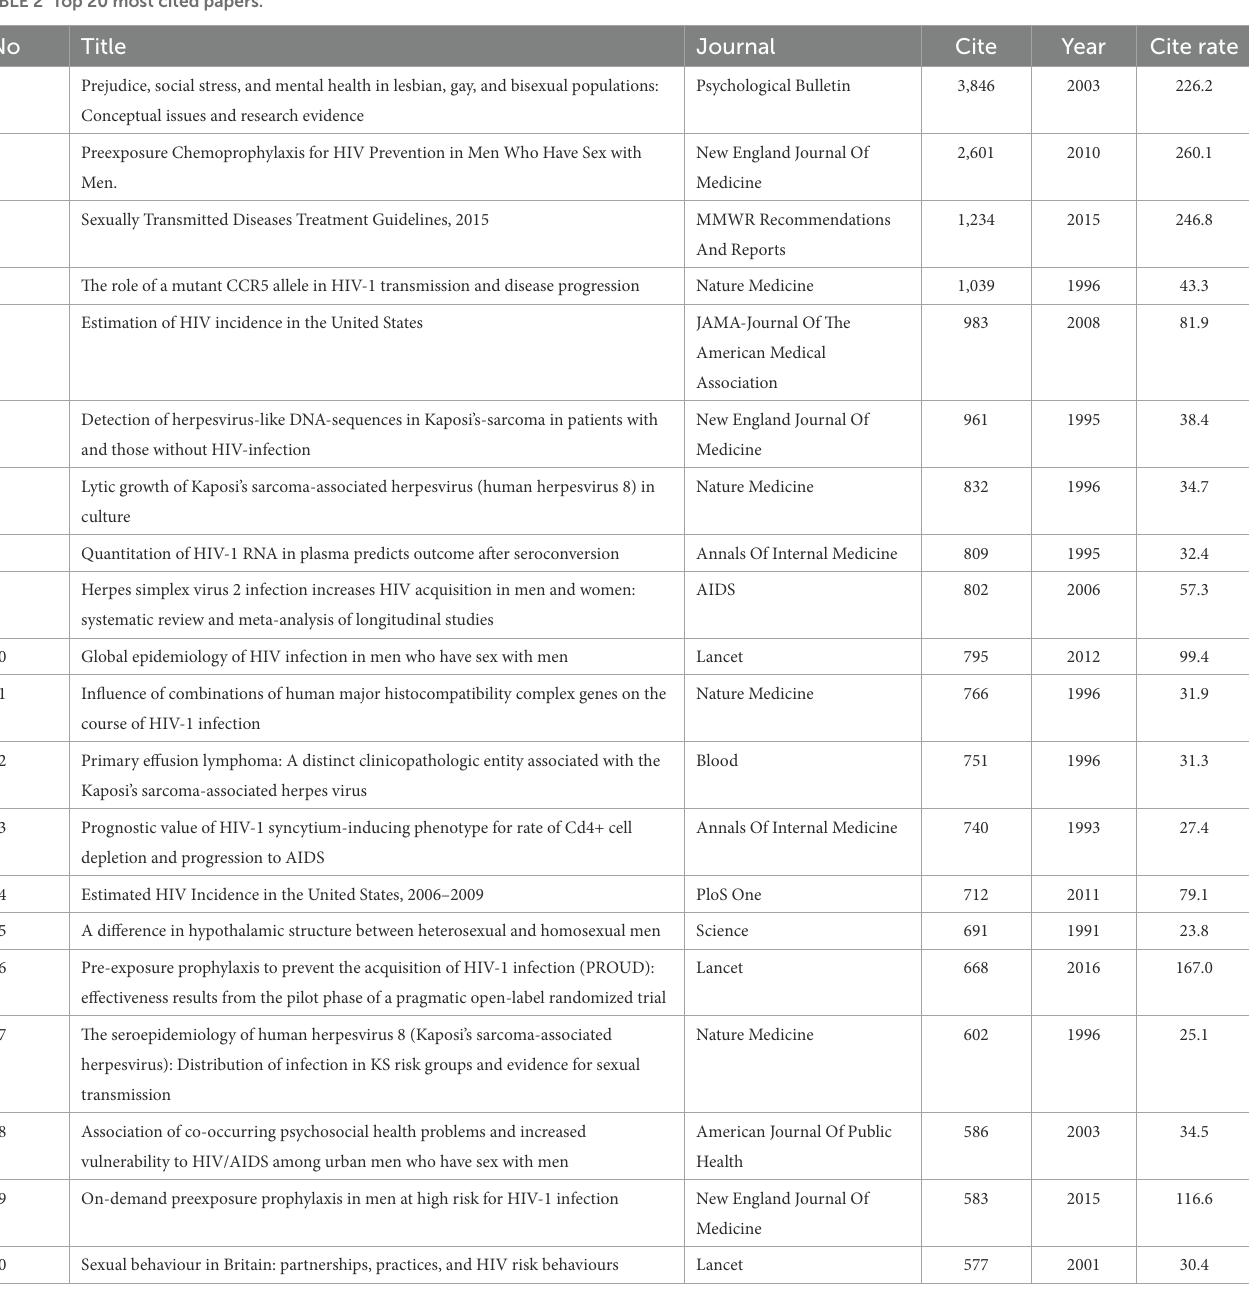
TABLE 2 Top 20 most cited